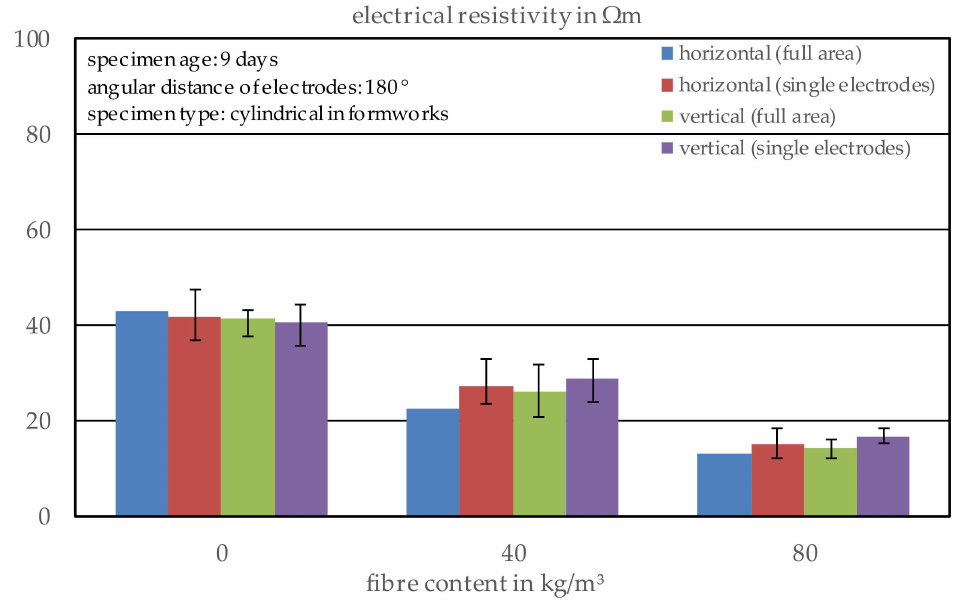
Figure 6. Electrical resistivity in different directions depending on fibre content at a specimen age of 9 days and an electrode array with angular distances of 180 ◦